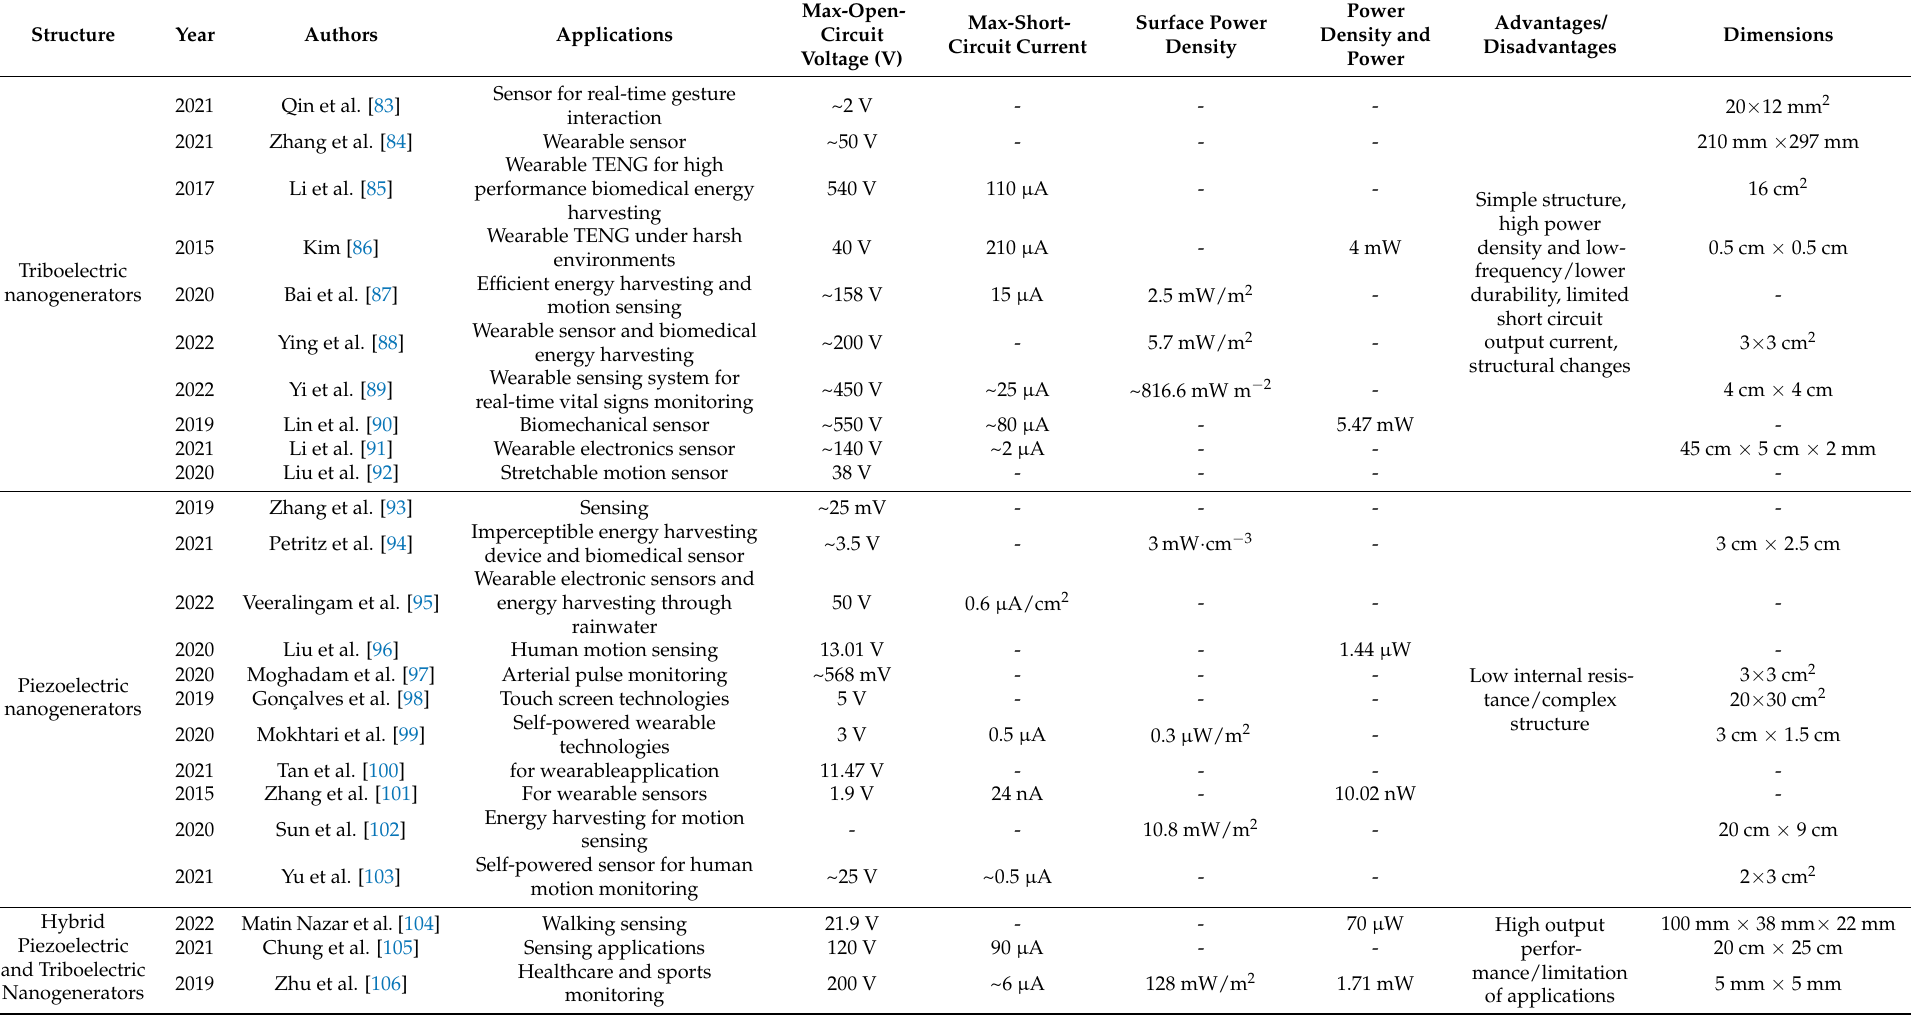
Table 1. Summary of various piezoelectric and triboelectric nanogenerators techniques for biomedical sensors. Structure